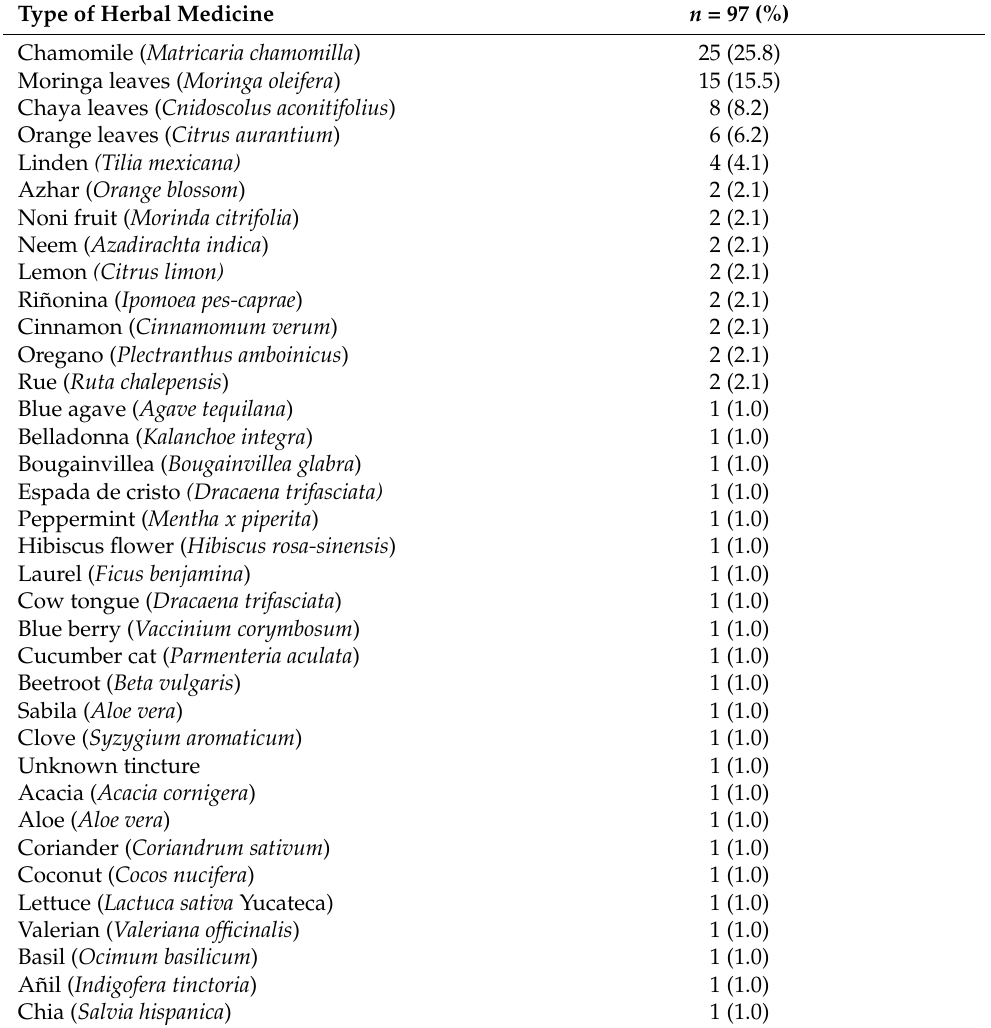
Table 3. Herbal medicine employed by